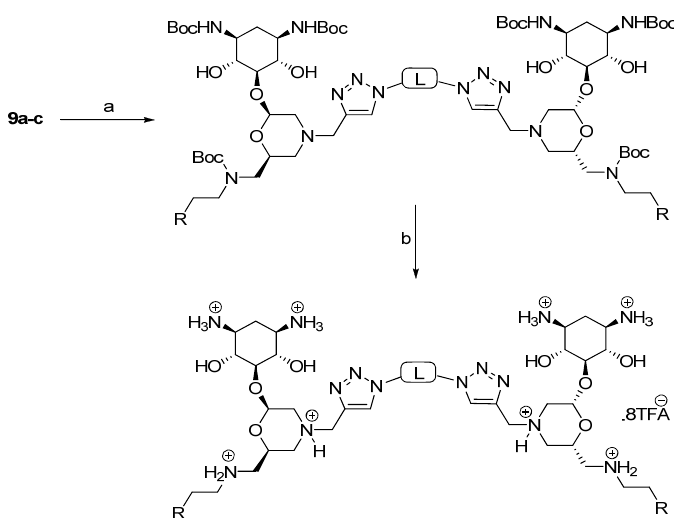
Scheme 4. Dimerization and deprotection of the conjugates.